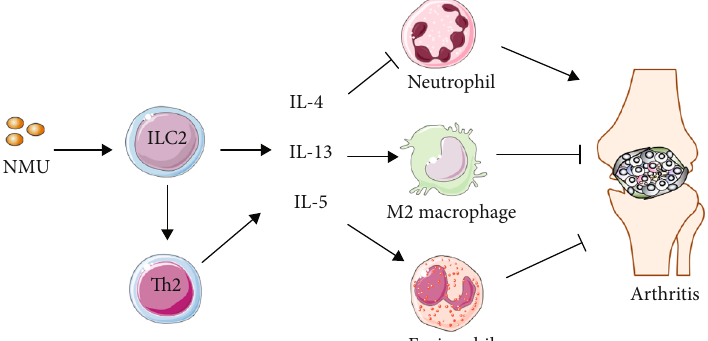
Figure 5: Mechanisms of suppression of arthritis induced by NMU. NMU stimulated ILC2 and subsequently activated Th2, leading to the production of IL-4, IL-13, and IL-5. These type 2 cytokines further activated eosinophils and anti-in fl ammatory M2 macrophages, together with decreased neutrophil activity, promoting resolution of